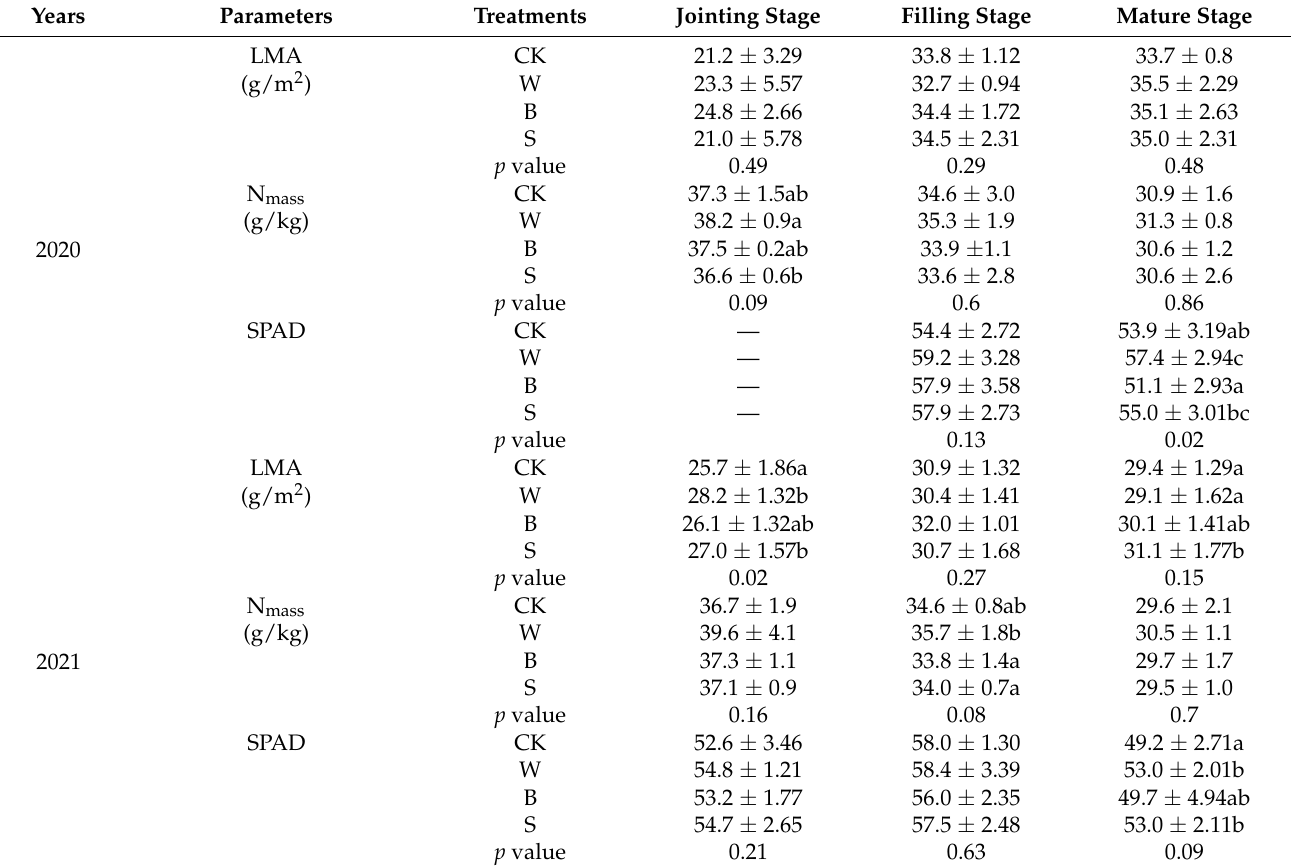
Table 4. Changes in biological factors of leaves among